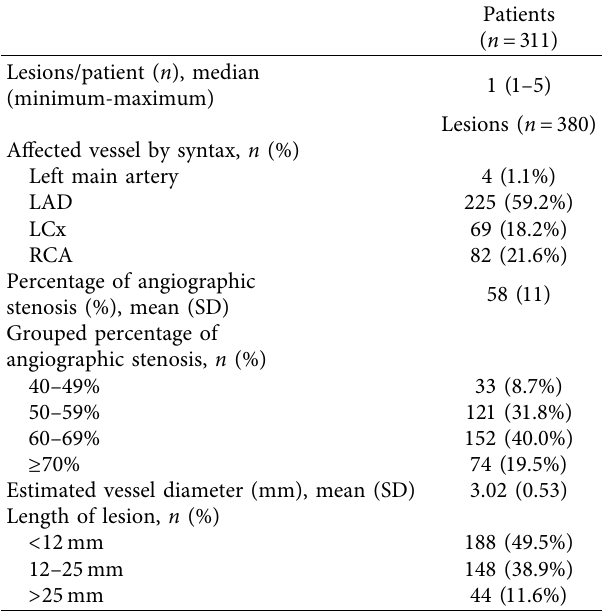
Table 2: Angiographic characteristics.